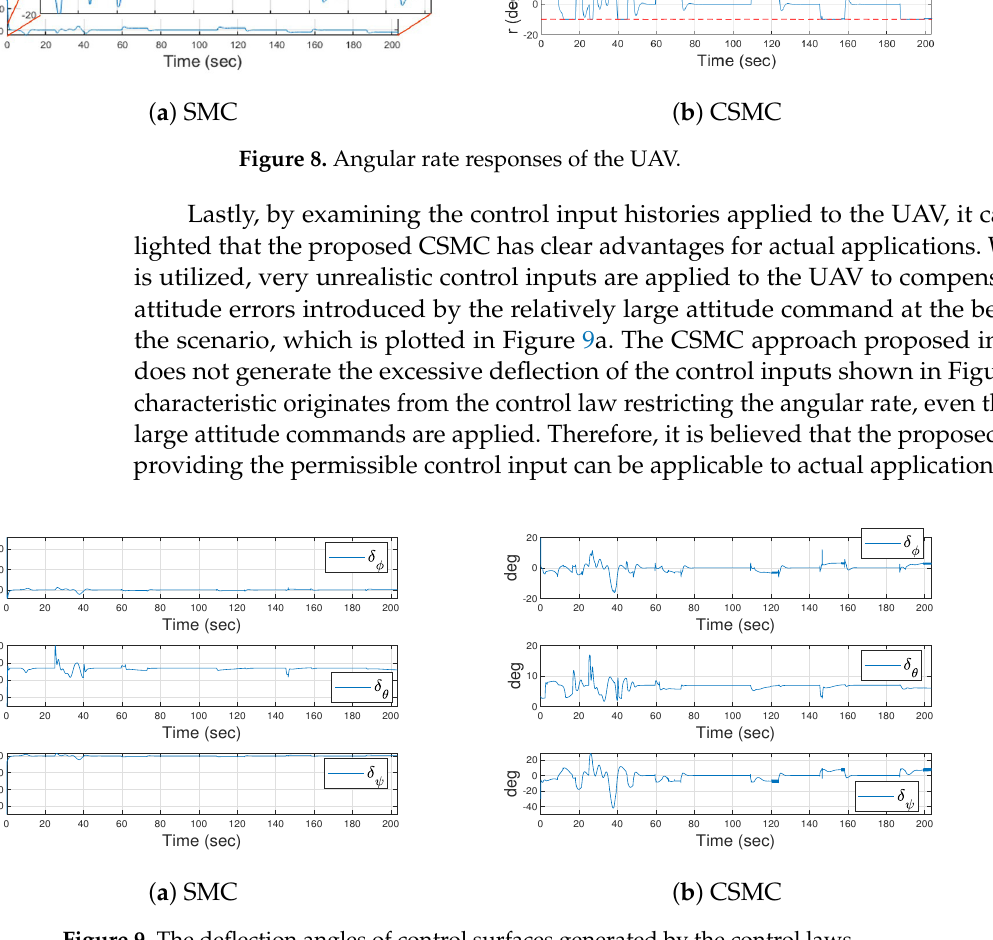
Figure 9. The deflection angles of control surfaces generated by the control